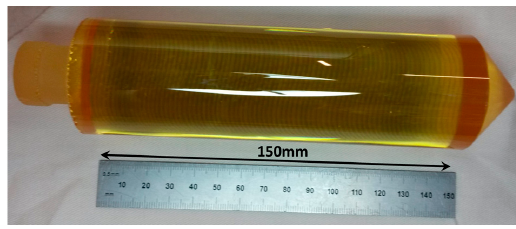
Figure 1. Tellurite bulk base glass fabricated by Kigre Inc.